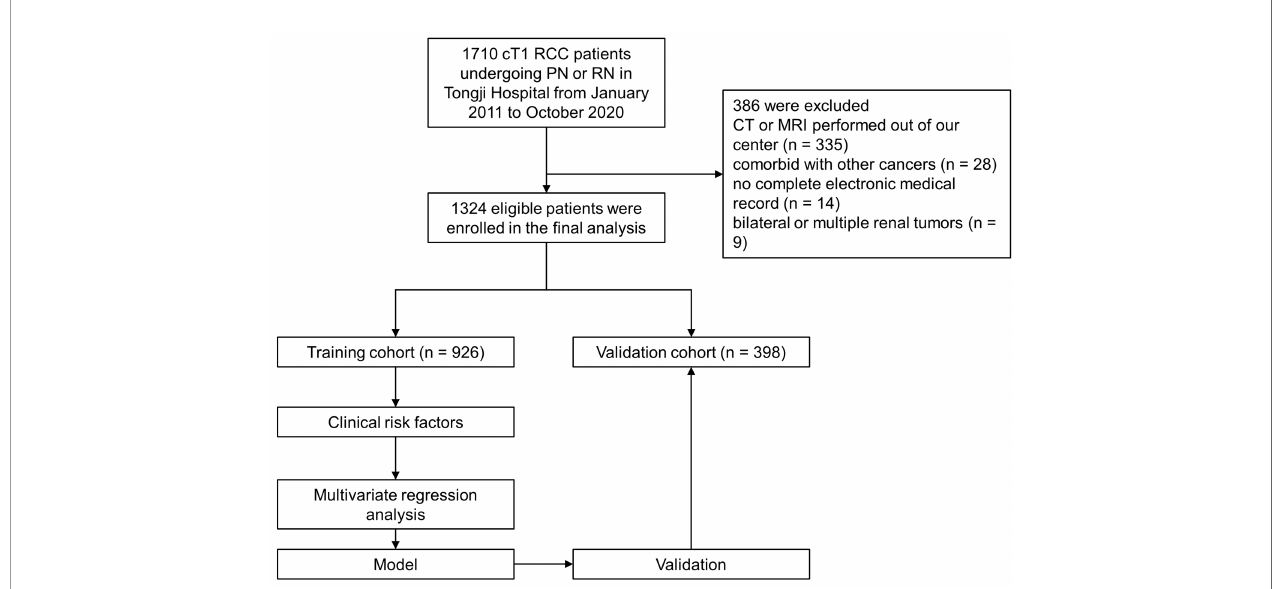
FIGURE 1 | Flow chart of the